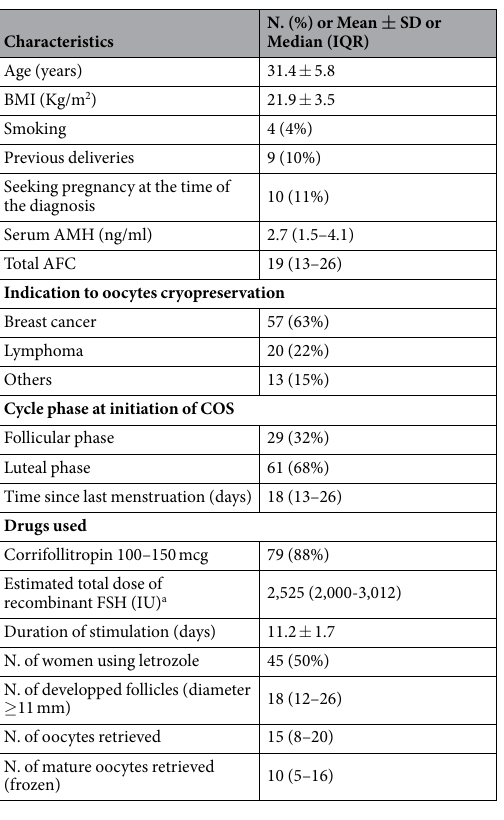
Table 1. Baseline characteristics and cycle outcome in the selected women (n = 90). IQR: Interquartile Range. N.: Number a Estimated total dose was calculated adding the total dose of daily gonadotropin administered to 1400 IU for those using also corrifollitropin 12 .